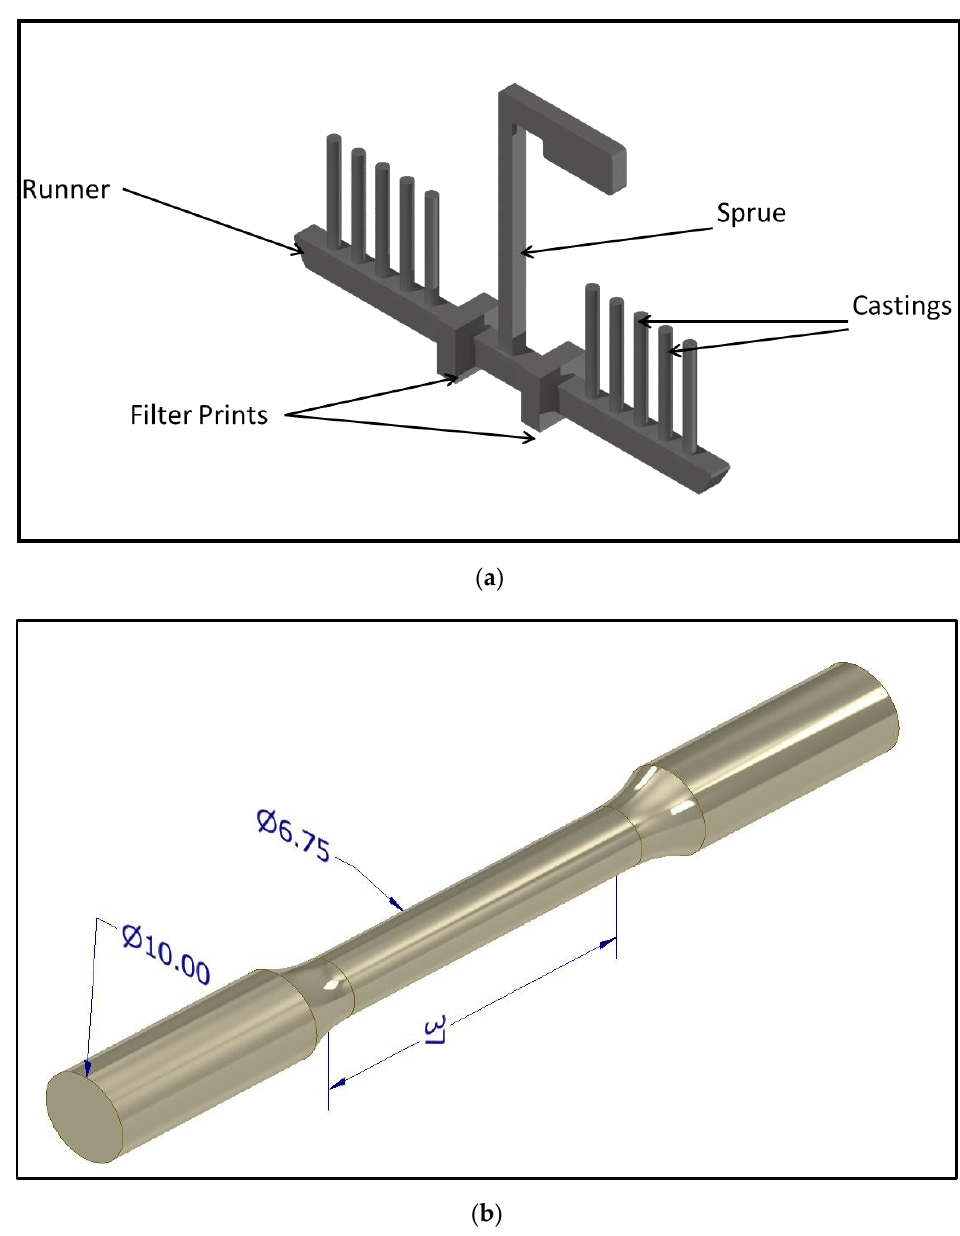
Figure 1. A schematic diagram of ( a ) the pattern used to create the mould, ( b ) a tensile test sample (dimensions in mm).